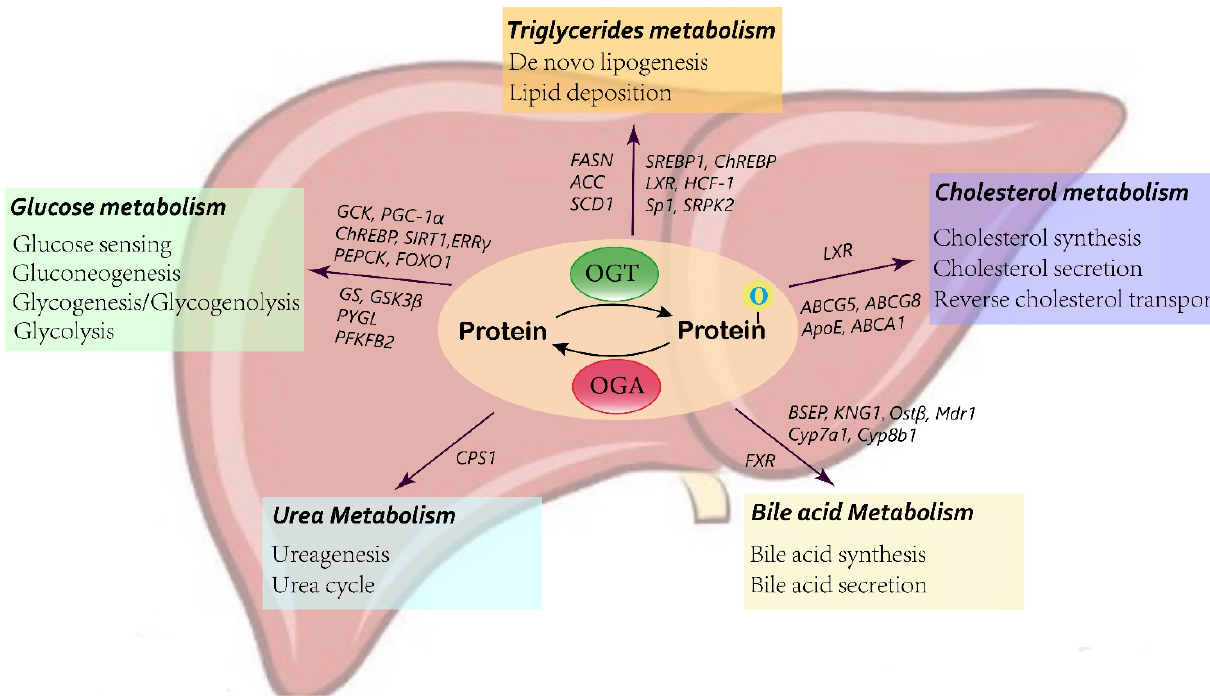
Figure 2. Schematic of O-GlcNAcylation in liver metabolism.